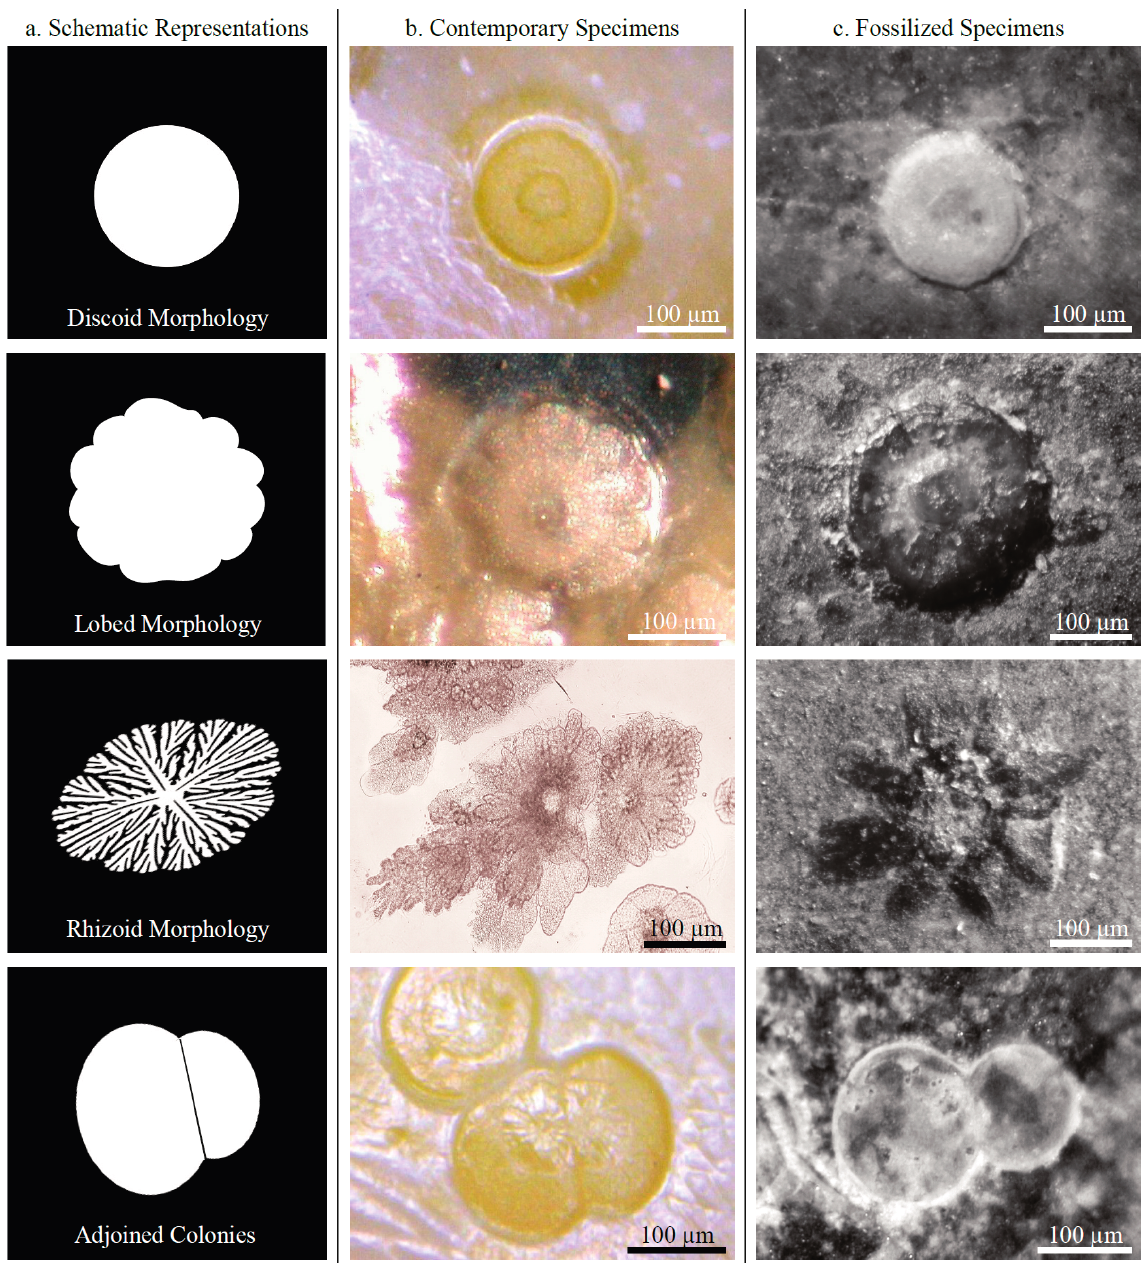
Figure 2. Morphologies of the investigated specimens of epibiotic calcifying bacterial colonies: schematic representations ( a ), photomicrographs of contemporary ( b ) and fossilized ( c ) specimens illustrating the discoid, the lobed and the rhizoid radial morphologies and showing adjoined